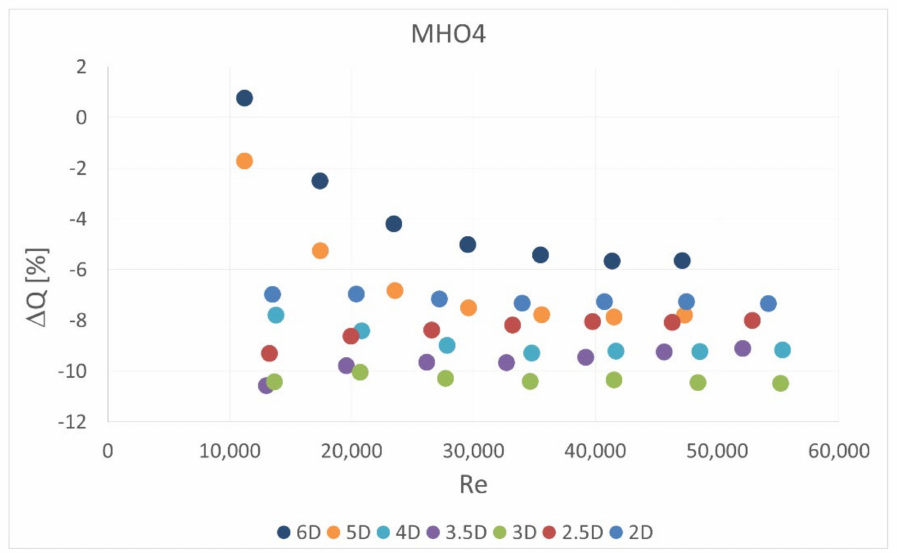
Figure 19. Measurement error of mass flow rate in MHO4 for disturbed